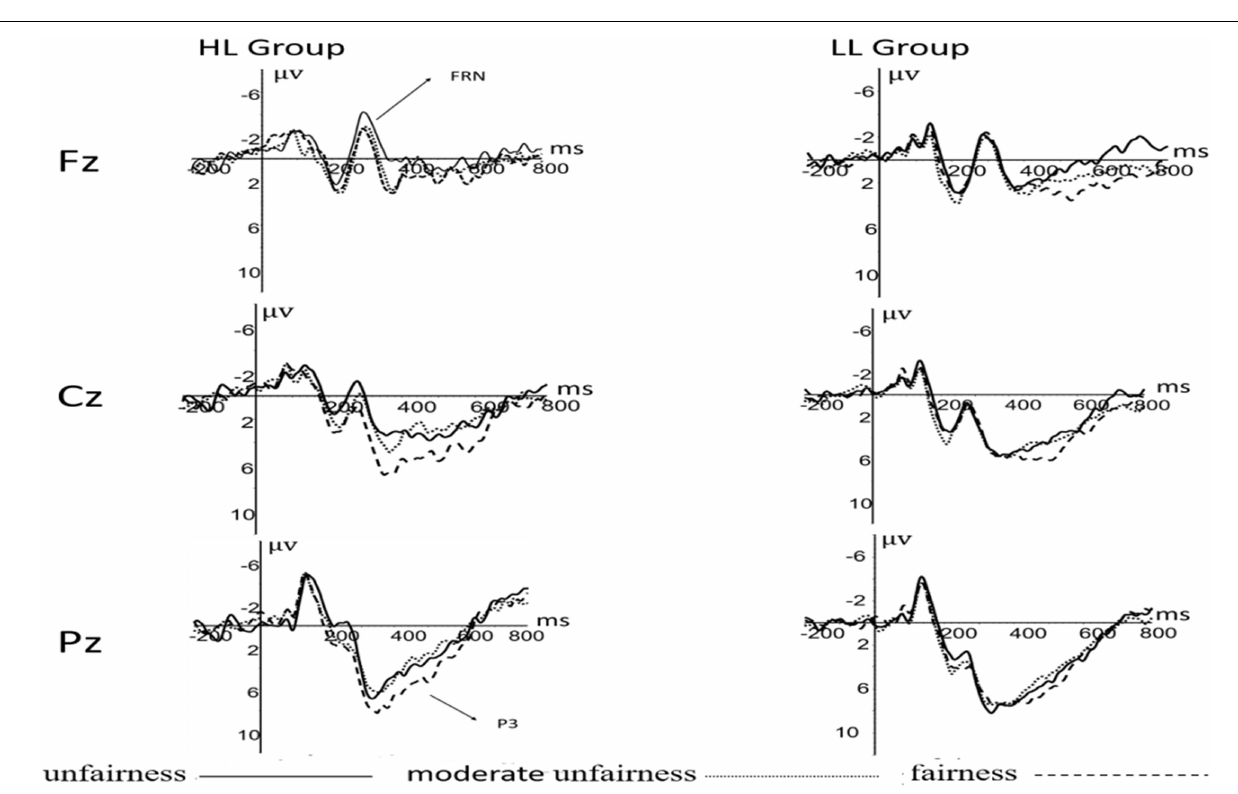
FIGURE 3 | P3, FRN components at Fz, Cz, Pz electrodes when the partner is